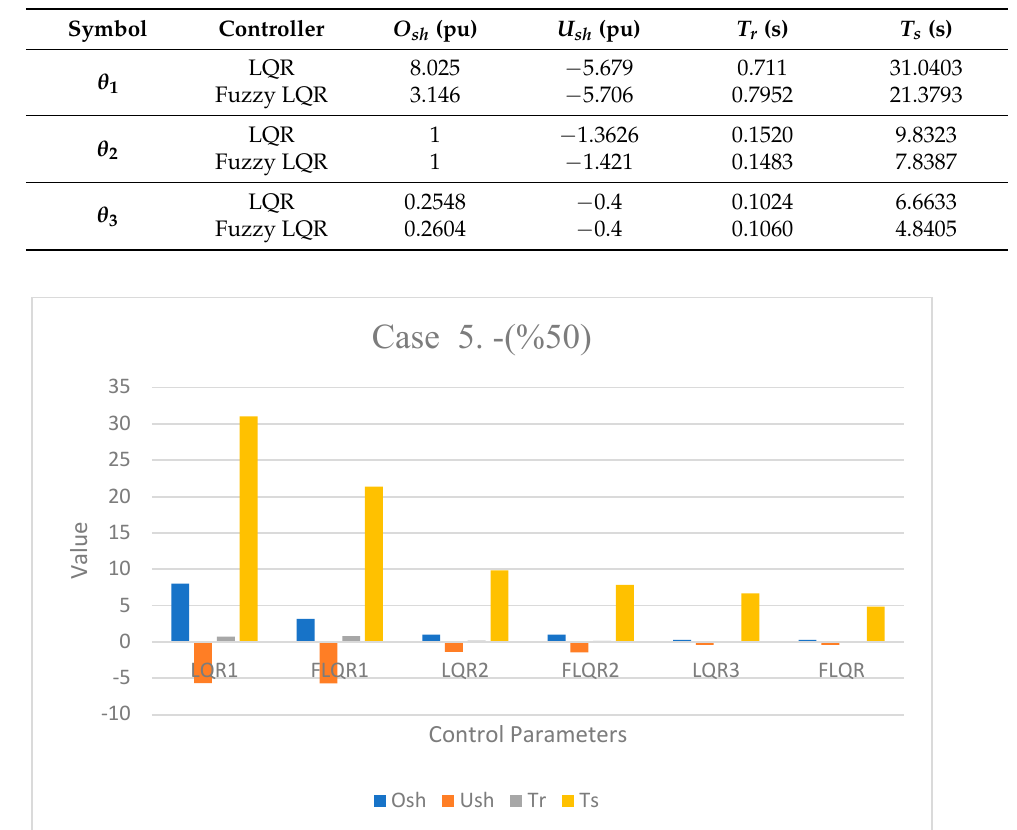
Table 8. Comparison performance of LQR and FLQR controllers in Case 5.